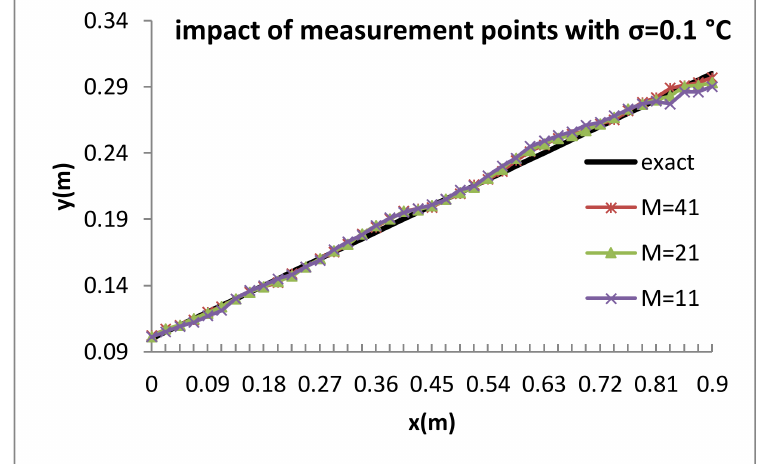
Figure 6. Identification results of di ff erent measurement points for inversion results of case 1.